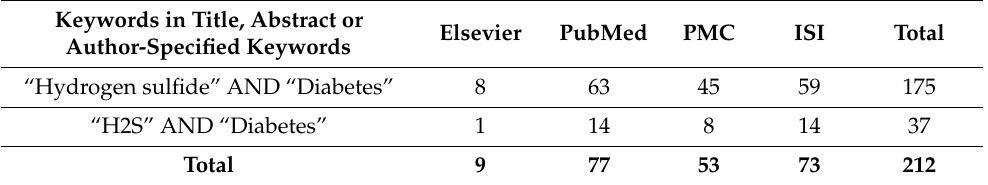
Table 1. The keyword combinations used for the contextual searches in the international databases.